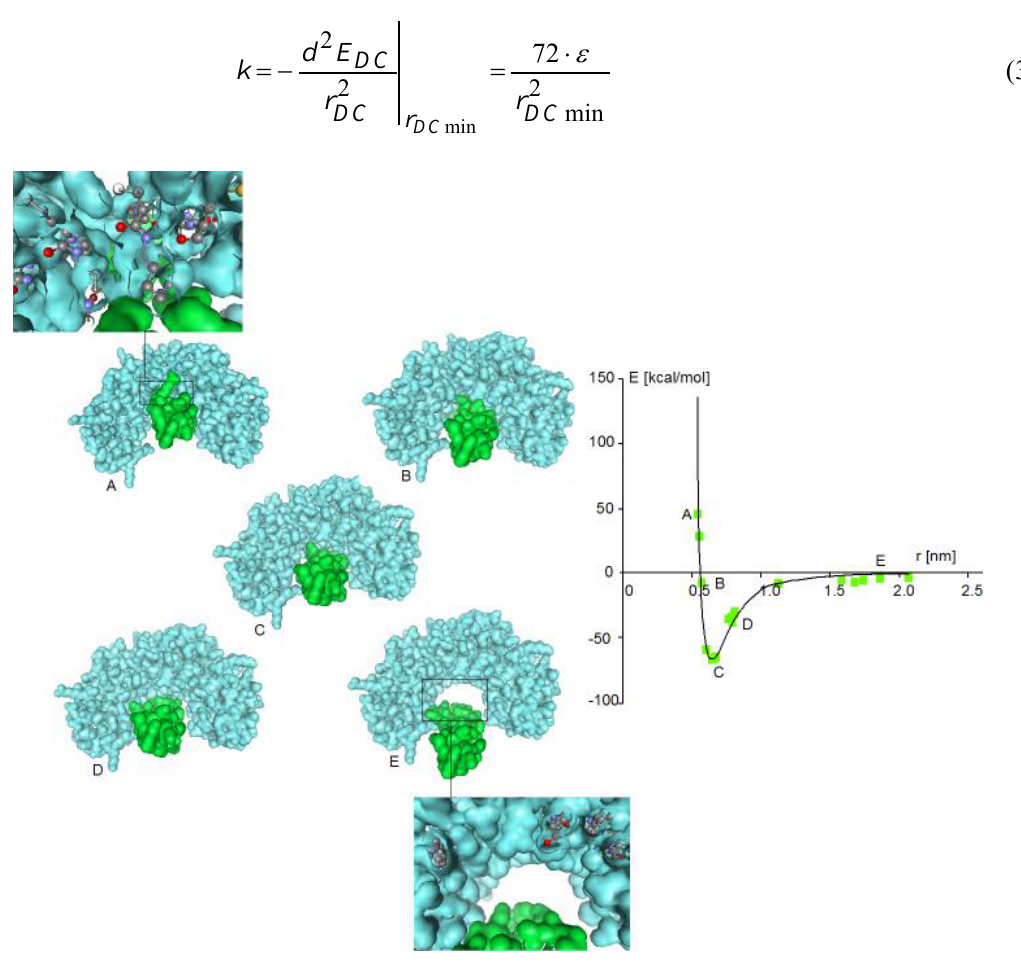
FIGURE 2. Collagen molecule-decorin core protein complex. The interaction between decorin core protein (in gray) and collagen molecule (in green) is evaluated for different intermolecular distances. The decorin concave surface is enlarged with reference to two simulations. Complex A is due to the collapse of the collagen within the decorin concave surface (highest energy value on graph), in the complex E decorin and collagen are too far and their interaction energy goes to zero (asymptotic value in the graph on the